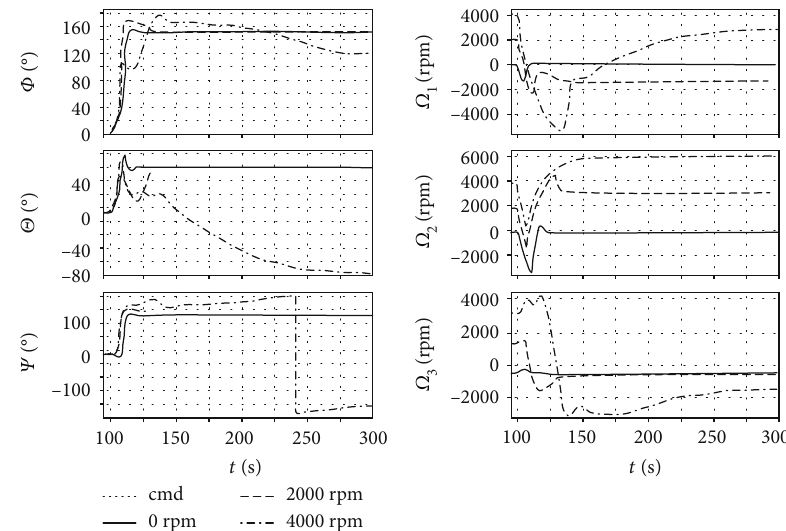
Figure 8: Nominal mode, case